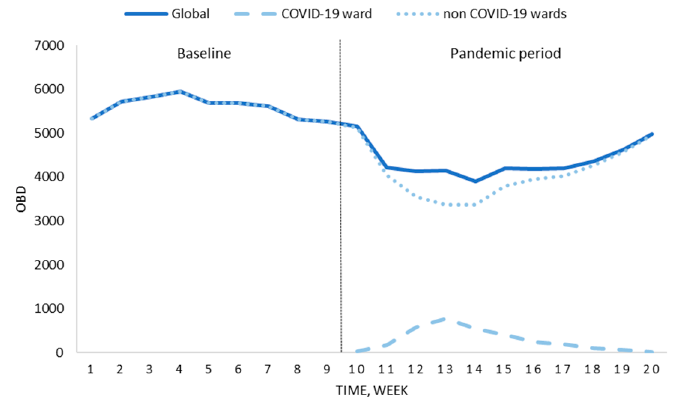
Figure 1. Changes in occupied bed days (OBD) before the national lockdown (baseline) and the pandemic period.